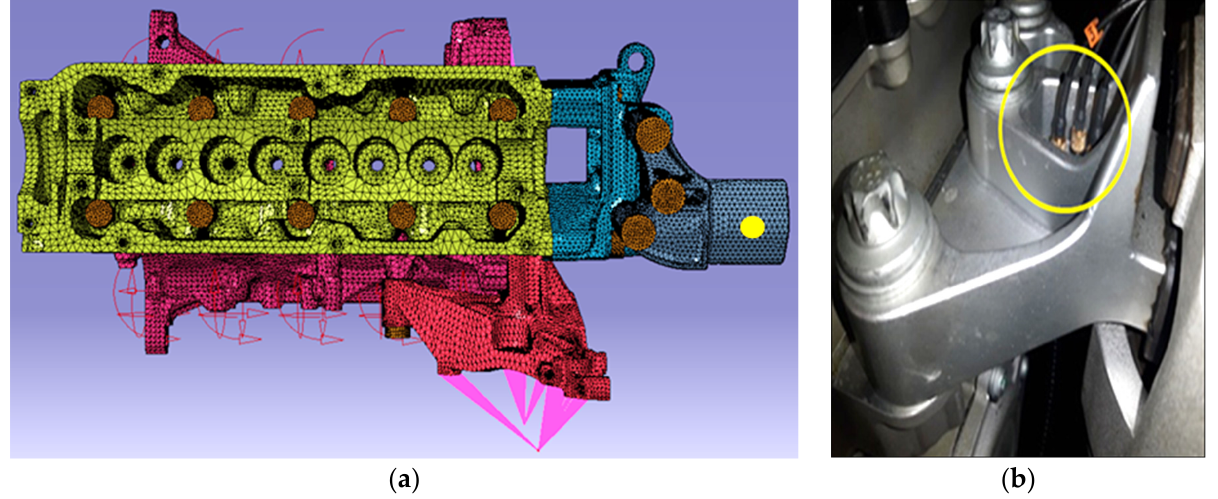
Figure 3. FEM simplified model with highlight of the reference position (yellow dot) for vibration excitation ( a ) and acceleration measurement nearby location ( b ).